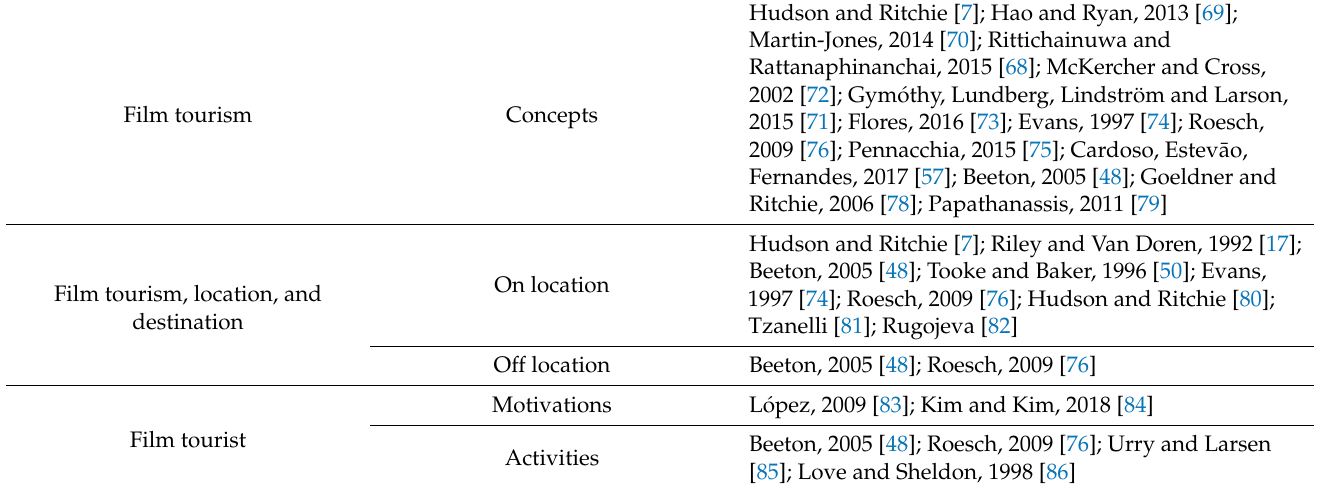
Table 3. Main issues of film tourism and